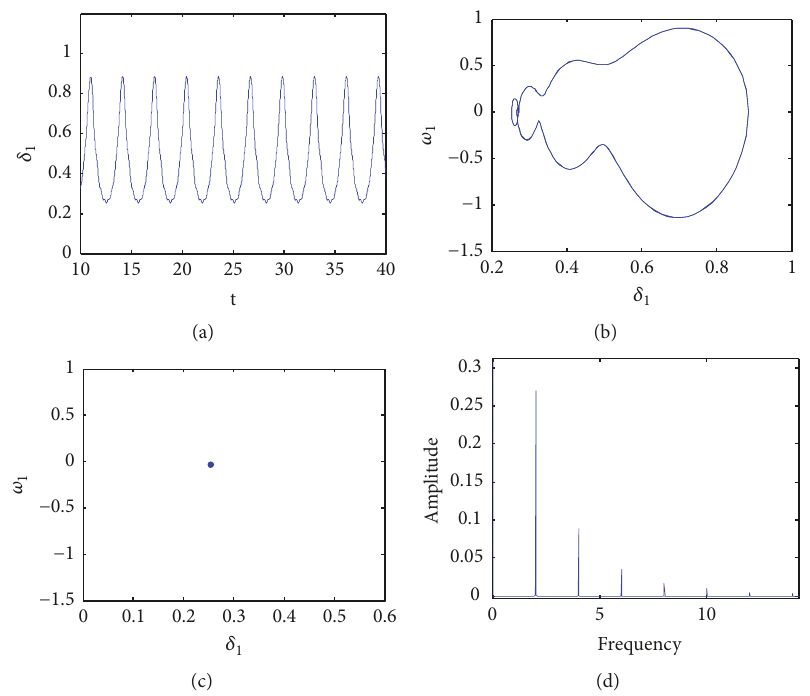
Figure 4: Period 1 motion ( 𝑉 𝐵1 = 0.5 ). (a) Time history. (b) Phase portrait. (c) Poincar´e map. (d) Frequency spectrum.